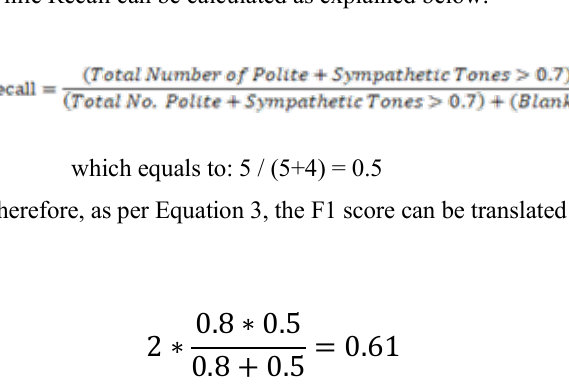
Table 19. Components of Precision and